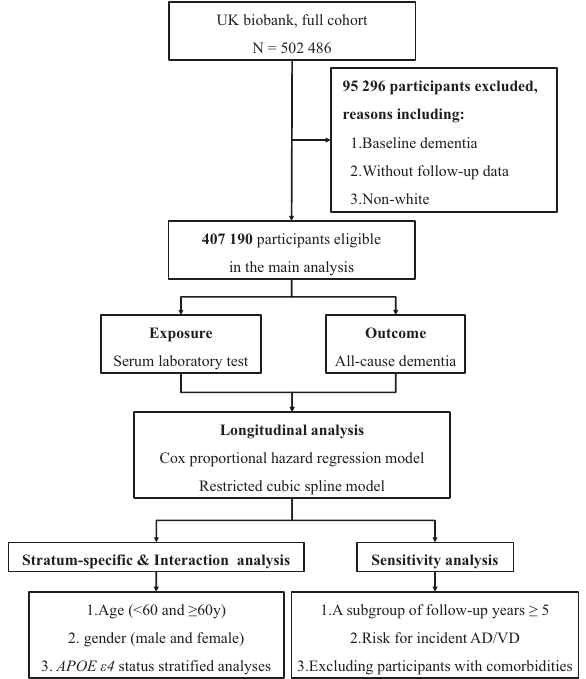
Fig. 1 Flow chart of the study design. Flow chart depicting the design and analytic approach of this study in